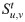
Inferring an edge Su,vt of our latent
dynamic graph (LDG) using two passes, according to (7)–(10), assuming an event between nodes u = 1 and v = 3 has occurred.Even though only nodes u and v have been involved in the event, to infer the edge Su,vt between them, interactions with all nodes in a graph are considered.